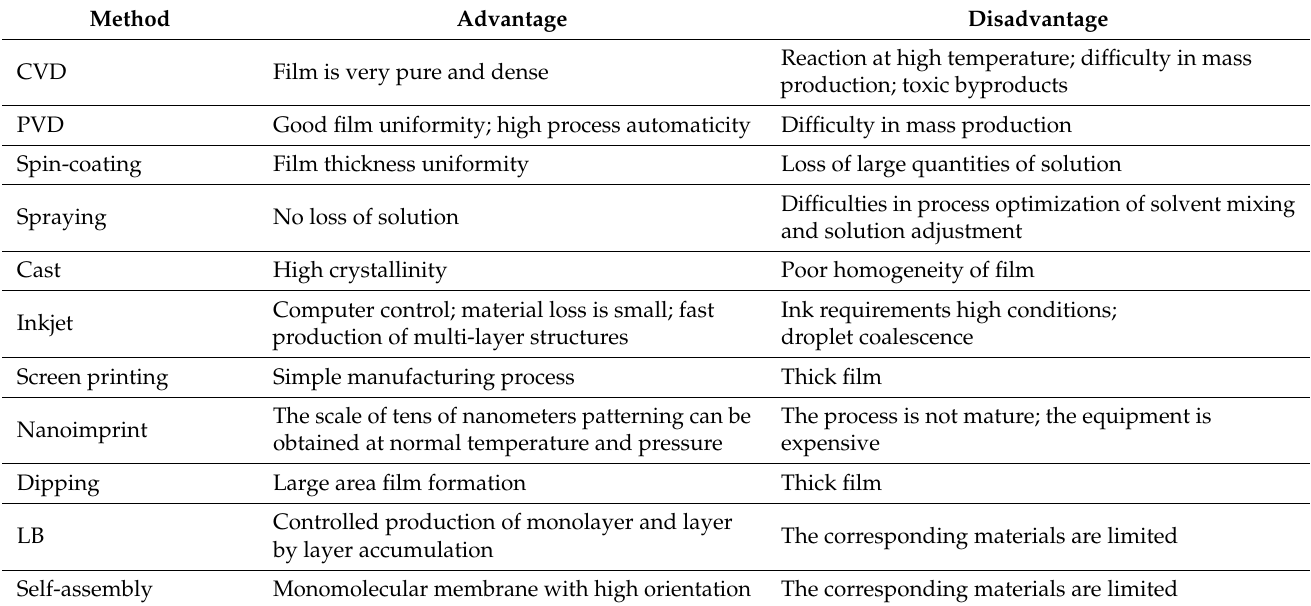
Table 1. The advantages and disadvantages of traditional